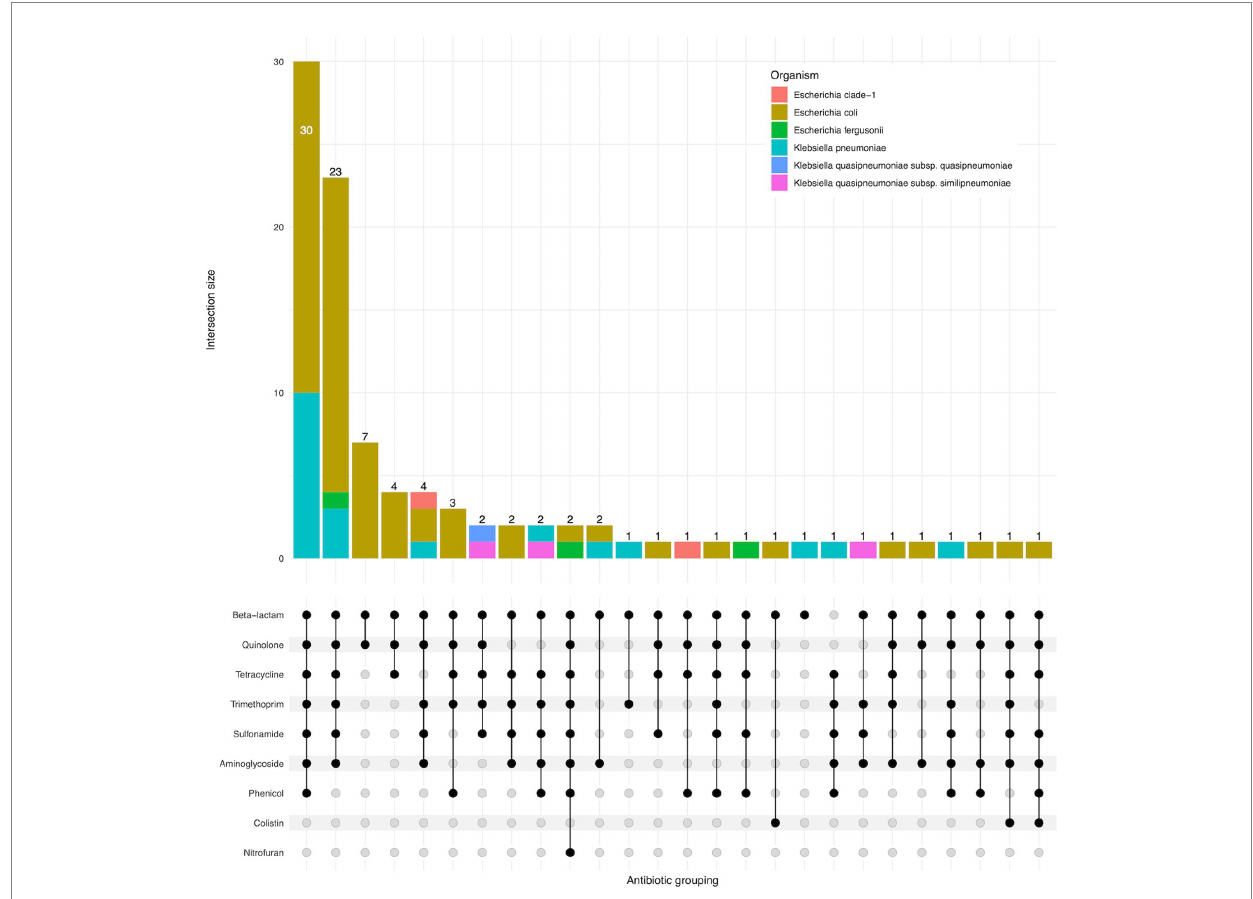
FIGURE 3 Upset plot showing shared classes of antimicrobial resistance genes between isolates. Isolate counts are shown as bars, with antimicrobial resistance gene combinations displayed in the lower